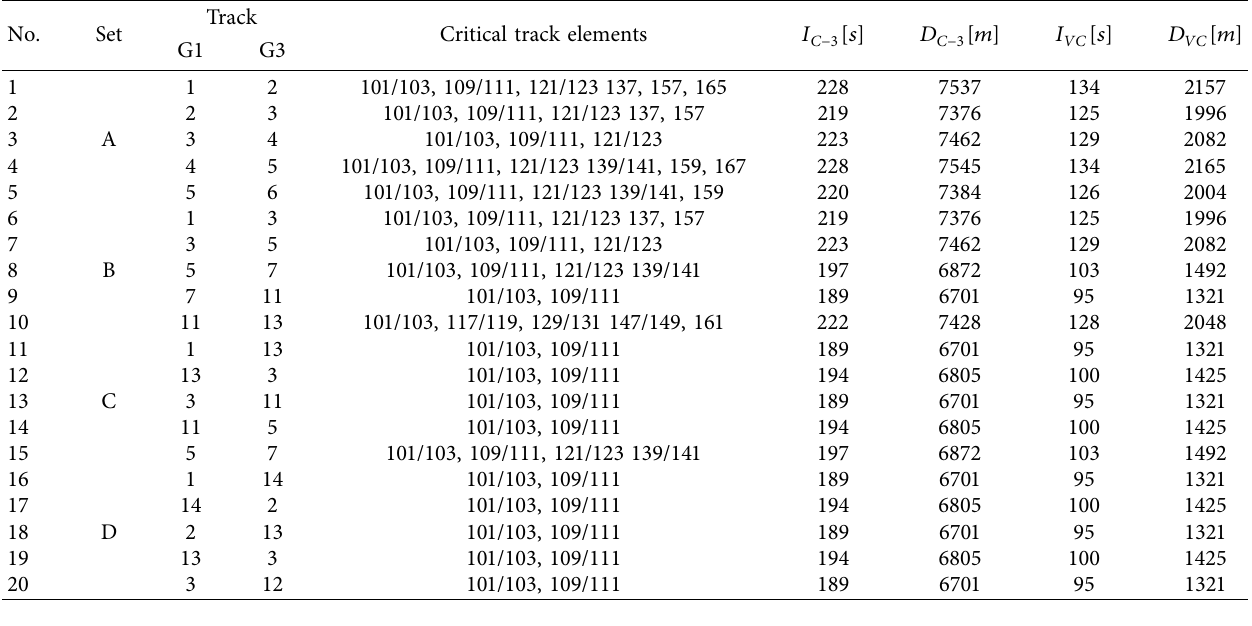
Table 7: Outcomes of train headways and distance in scenario 3.